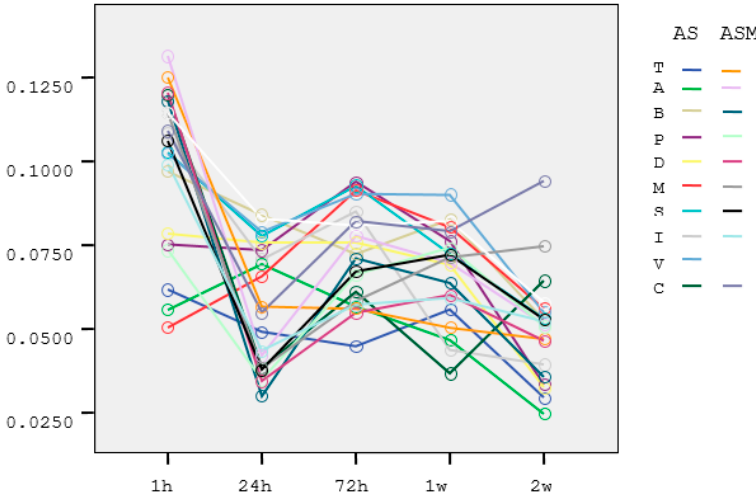
Figure 2. Means of absorbant index at 24 h. Different colors shows the absorbant values of the materials (T, A, B, P, D, M, S, I, V) and the control group in artificial saliva (AS) and artificial saliva with melatonin (ASM).